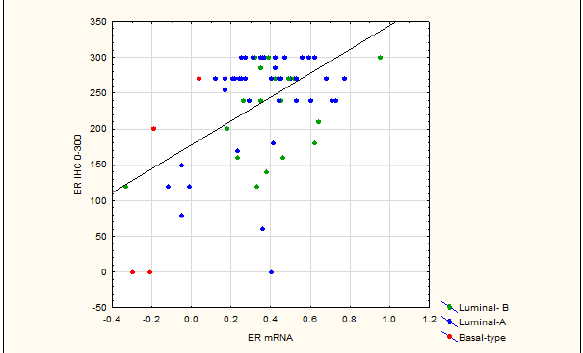
Scatterplot showing the relationship between oestrogen receptor (ER) immunohistochemistry (IHC) score and mRNA score; Spearman R =0.34 ( p =0.00).